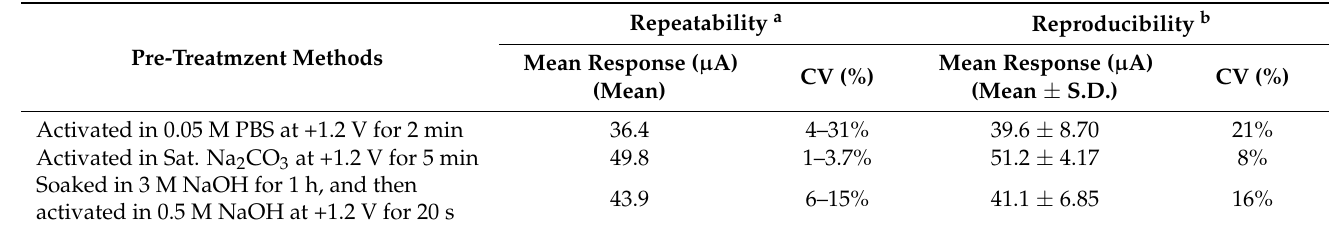
Table 1. Repeatability and reproducibility of the electrochemical response of SPCEs after various pretreated processes. Amperometric responses of SPCEs in 4 mM K 3 [Fe(CN) 6 ]/1 M KCl at +0.5 V vs. Ag/AgCl.